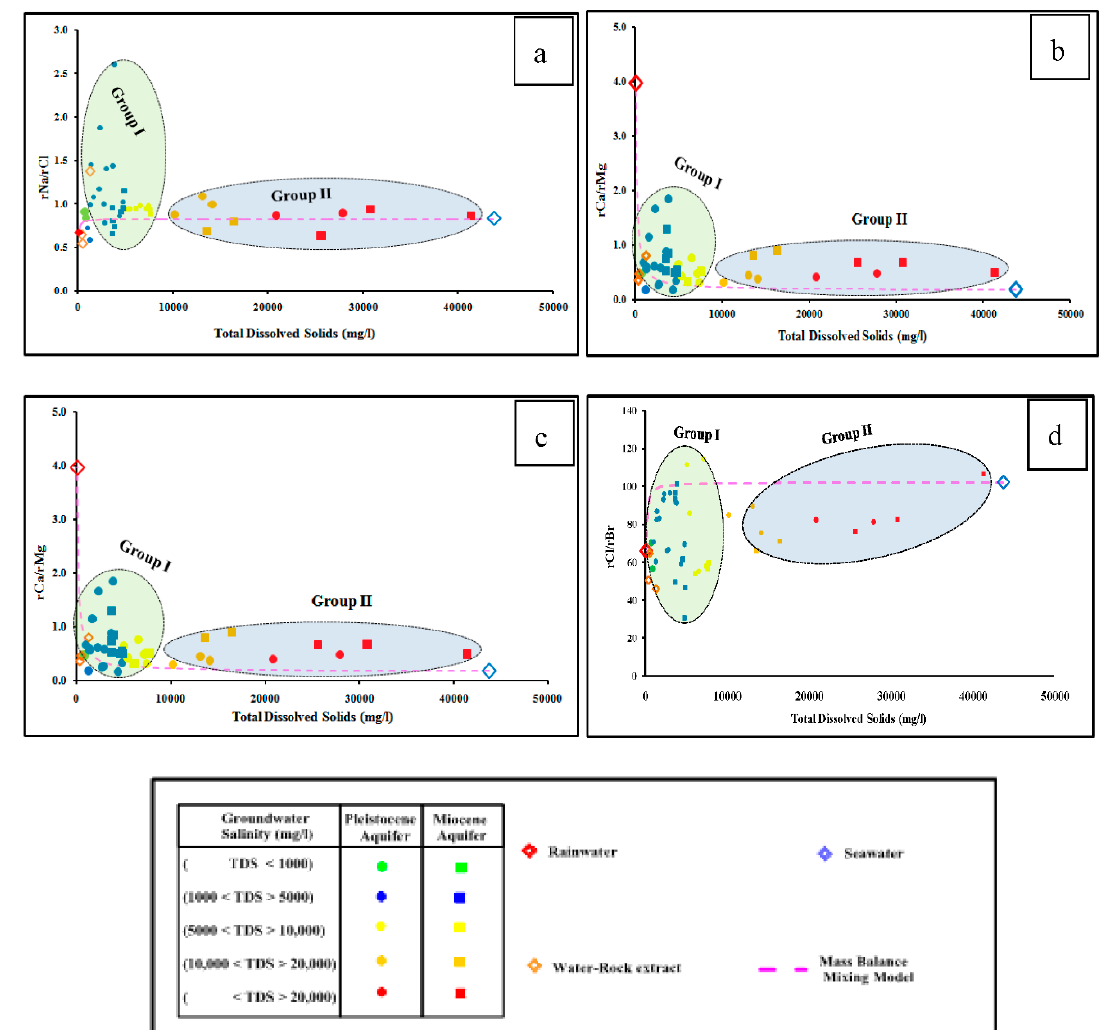
Figure 5. Ion ratios (( a ) rNa + /rCl − , ( b ) rCa 2+ /rMg 2+ , ( c ) rSO 4 2 − /rCl − and ( d ) Br − /Cl − ) of the studied groundwater samples versus the total dissolved solids.